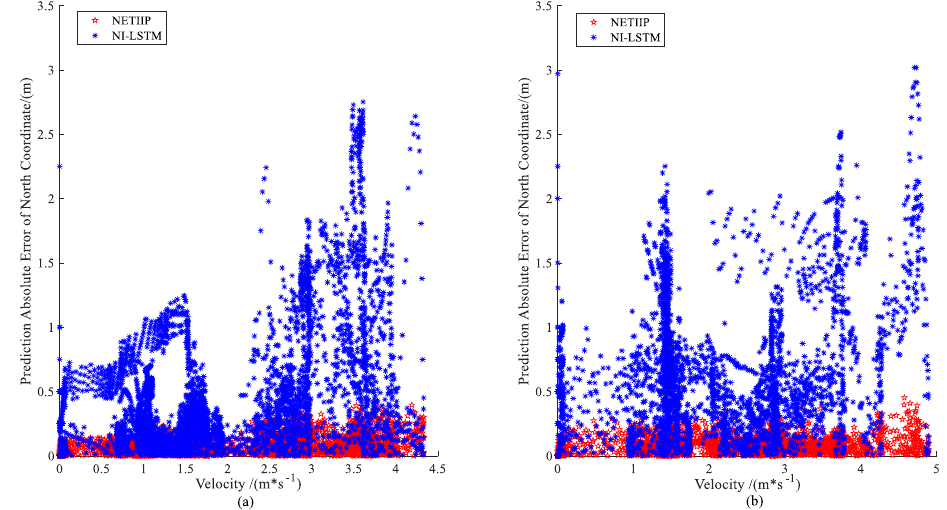
Figure 14. Prediction error – velocity distribution of ship position: ( a ) MRM and ( b ) ANM.